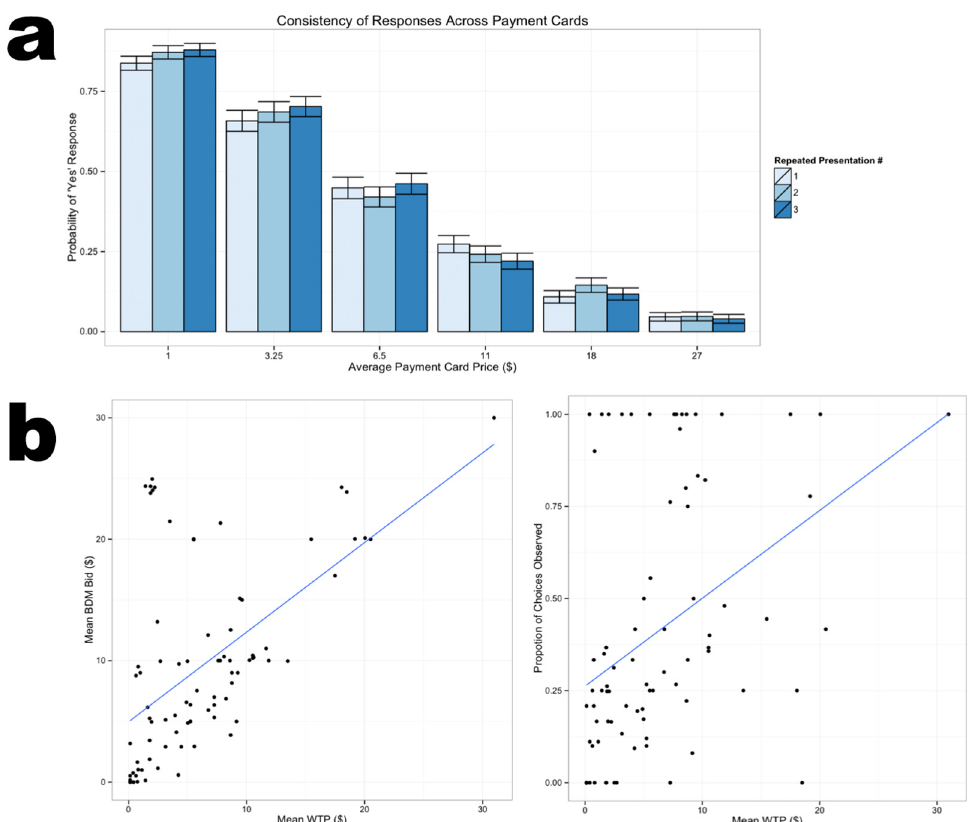
Fig 4. (a) Choice probabilities of subjects for each payment card range did not vary significantly across any and all repetitions that were randomly interleaved across the behavioral session. (b) Correlations between alternative measures of environmental preferences. An extended sample (N = 15) submitted bids and choices in addition to the payment card with the exact same environmental proposals as a measure of consistency. Left: Correlation between mean WTP willingness-to-pay and mean BDM bid for each proposal ( r = 0.55, p < 0.01). Right: Correlation between mean willingness-to-pay for each proposal and choices observed ( r = 0.39, p < 0.01) between environmental